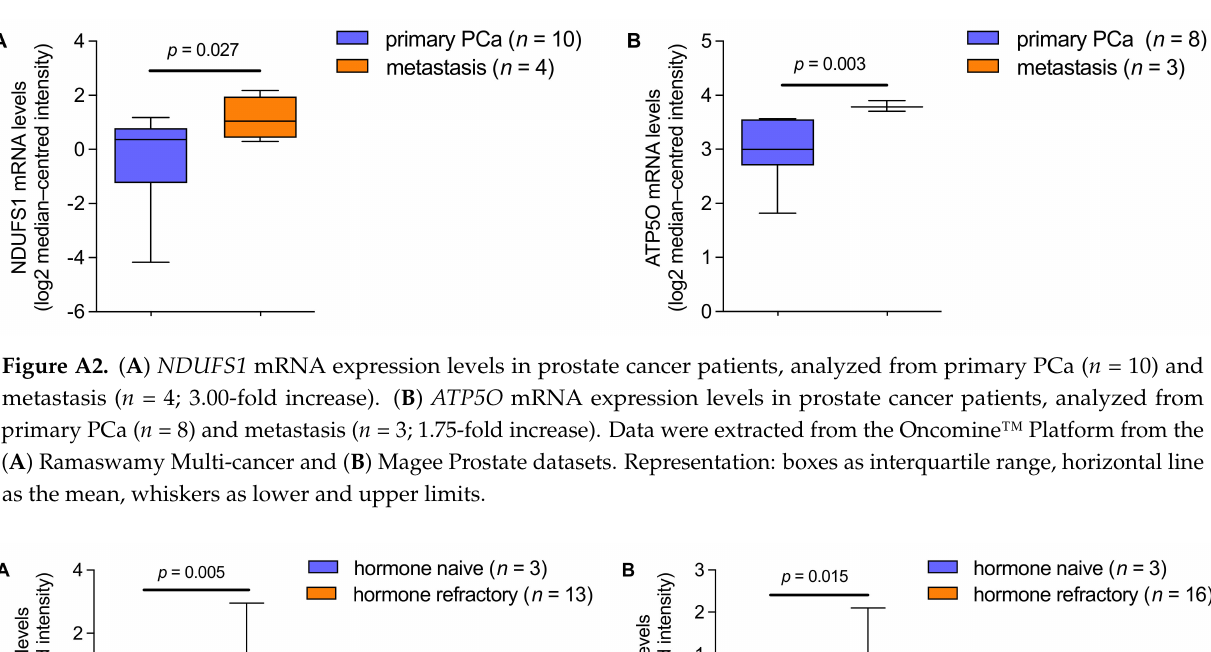
Figure A1. ( A ) Kaplan-Meier plot showing the time of biochemical recurrence in months for GSC in the IHC cohort ( n = 68). P -values were estimated by log-rank test. ( B ) Kaplan-Meier plot showing the time of BCR in months for ISUP in the IHC cohort ( n = 69). P -values were estimated by log-rank test.